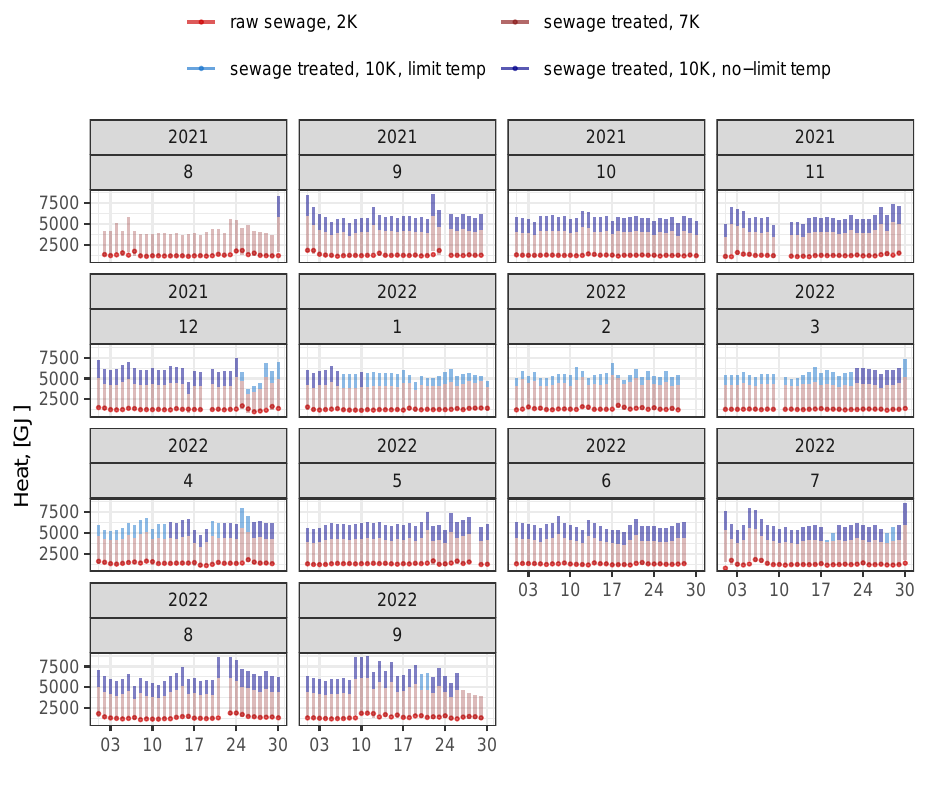
Figure 10. The range of the daily amount of heat that can be recovered when cooling the treated wastewater in the range of 2–7 K and the amount of heat from raw wastewater when cooled by 2